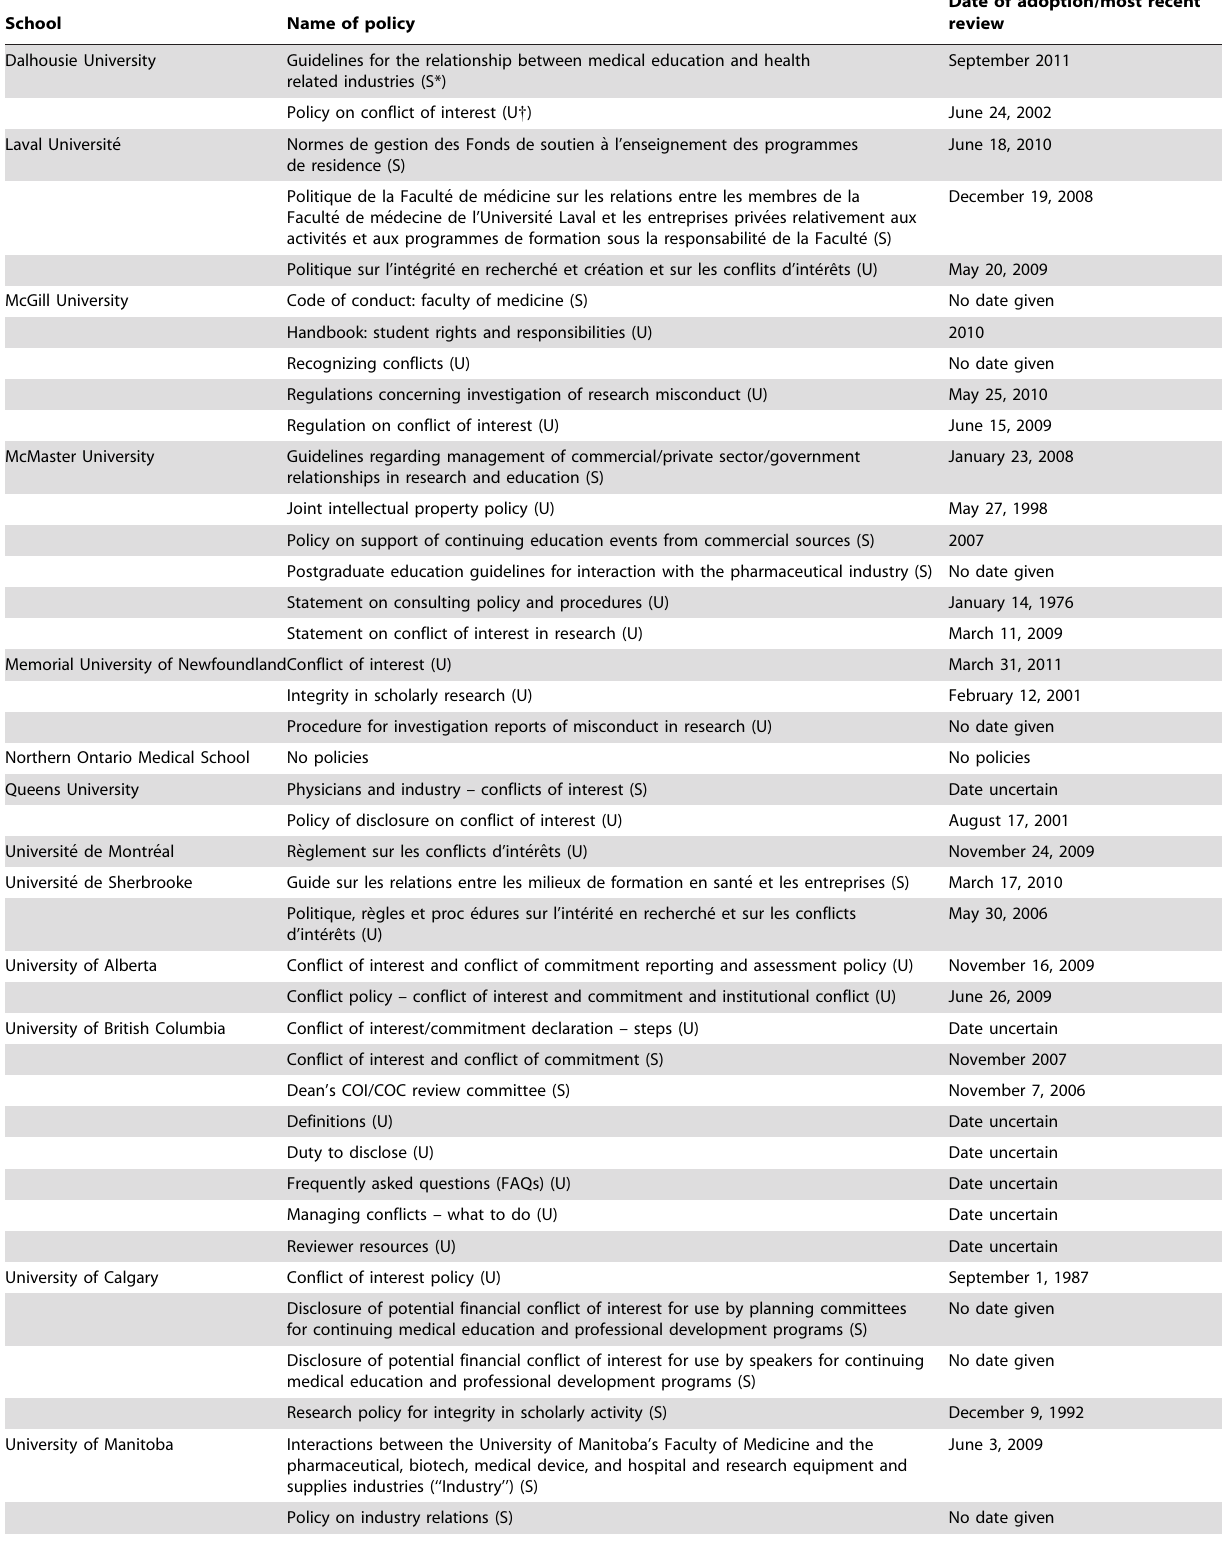
Table 1. Policies per school and date of each